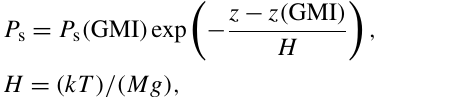
Figure A1. An illustration of collocating the high-resolution MODIS BRDF data with an OMI pixel FOV. Sample space is de- fined as the MODIS data space that encloses the entire OMI pixel polygon. N in is the number of MODIS data points within the OMI pixel (red dots). Numbers at each pixel corner indicate its geoloca- tion (longitude, latitude). Two pixels are selected: cross-track posi- tion 03 (near the edge of swath) and cross-track position 30 (near nadir) for orbit 12399 with along-track position